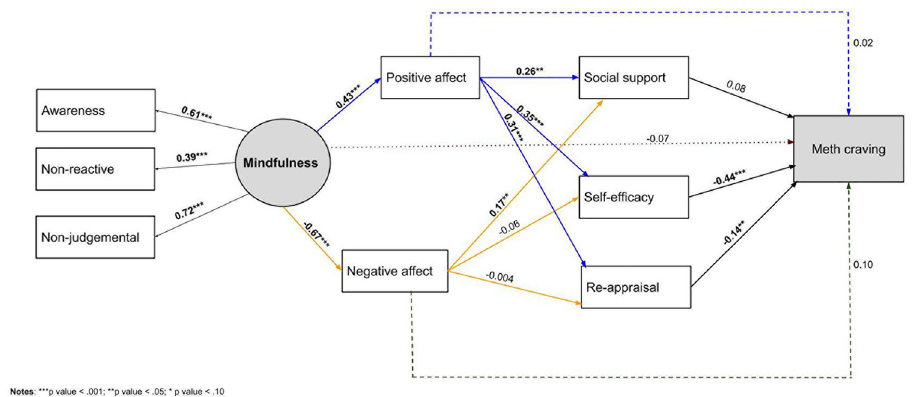
Fig 2. Standardized path analysis coefficients for the model examining the relationship between dispositional mindfulness and methamphetamine